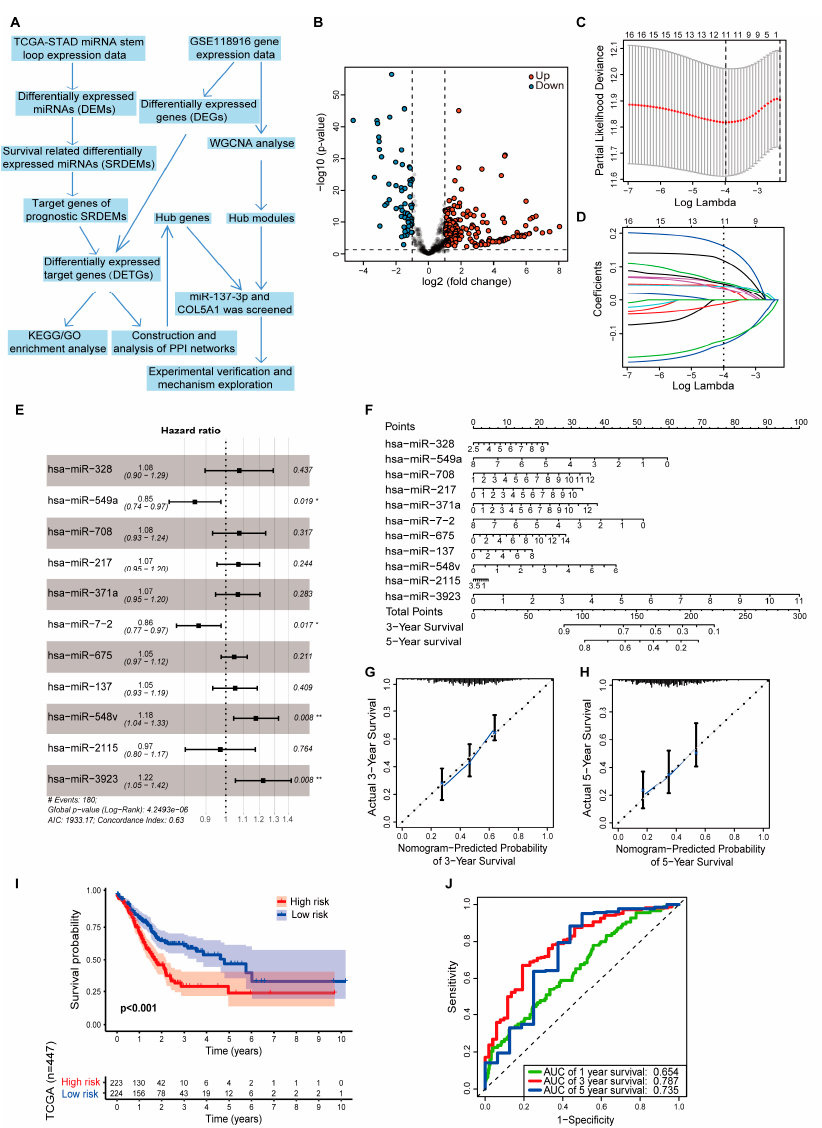
Figure 1. A prognostic model of GC was constructed on the basis of SRDEMs. ( A ) Flow chart of this study. ( B ) Volcano plot of DEMs in TCGA. Red represents upregulation, and blue represents downregulation. ( C , D ) Lasso regression analysis was conducted. The vertical dotted line in subfigure C corresponds to the penalty value of the lowest point (the upper coordinate corresponding to the lowest point of the red curve). Different curves in subfigure D represent different miRNAs. Make a vertical line at the position of the this penalty value in subfigure D, then the number of intersection points is the number of variables included in the final model, and the ordinate of the corresponding intersection point is the regression coefficient of the variable. ( E ) Forest plot of multivariate Cox analysis based on SRDEMs. ( F ) Nomogram of the prognostic model. According to the contribution of each factor in the model (the regression coefficient), each value of factor is scored, and then the total score is obtained by adding each score. The predicted outcome is calculated through the functional conversion relationship between each total score and the individual outcome. Calibration charts of 3-year ( G ) or 5-year ( H ) survival based on the prognostic model. ( I ) Kaplan–Meier survival curves for high-risk and low-risk groups. ( J ) The 1-, 3-, and 5-year ROC curves of the model were